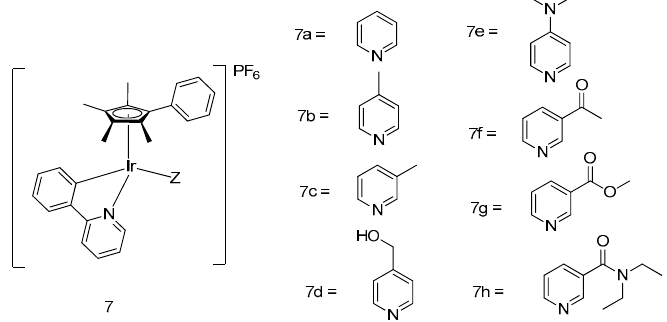
Figure 2 . Varying the monodentate ligand in organometallic half-sandwich iridium(III) compounds. Figure 2. Varying the monodentate ligand in organometallic half-sandwich iridium(III)